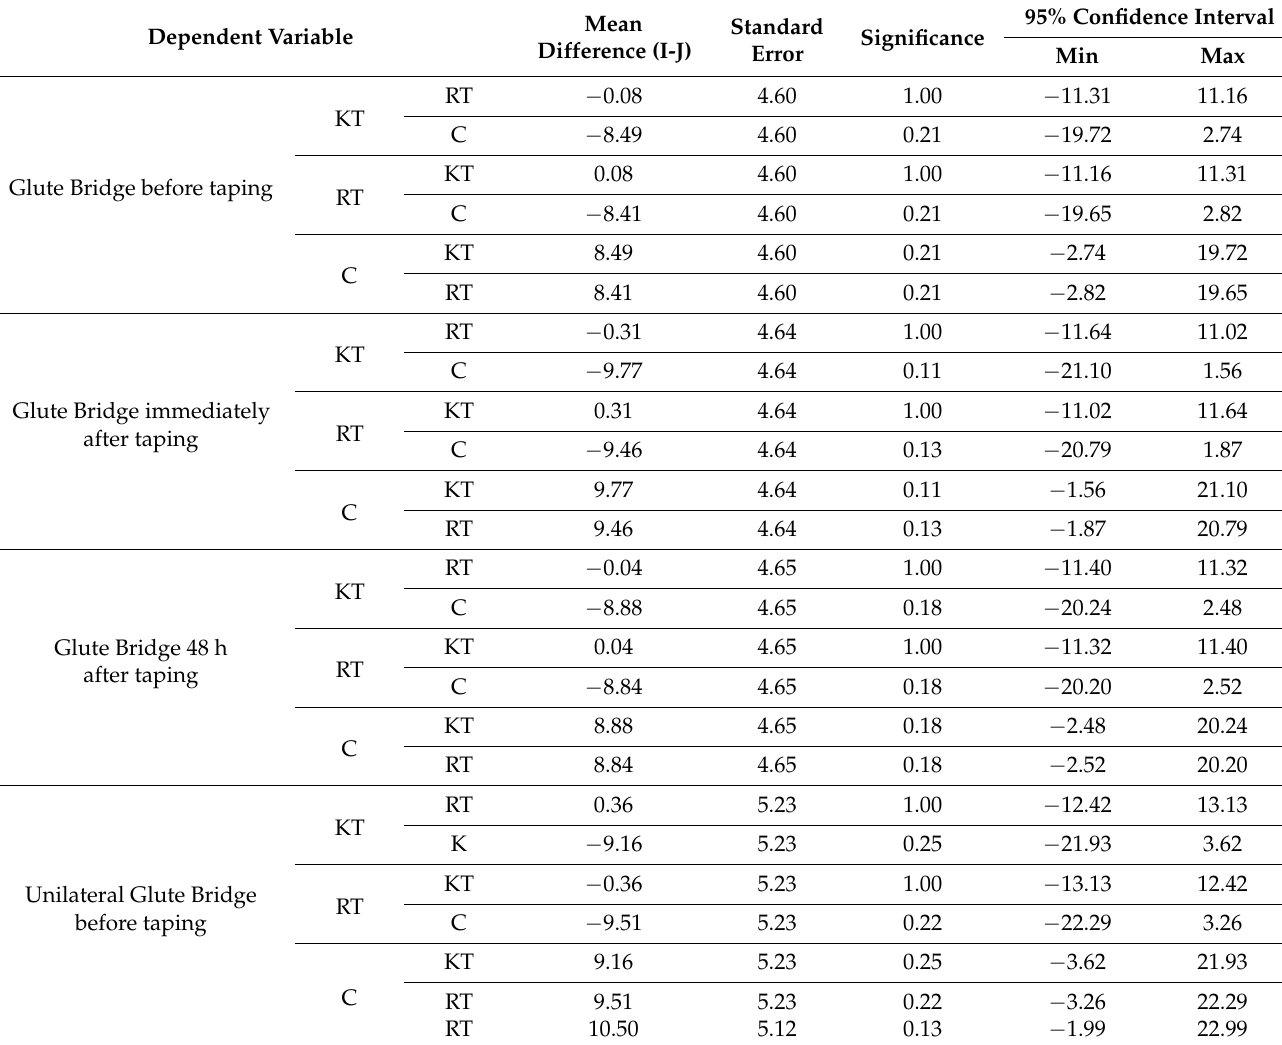
Table 3. Group differences in results obtained for particular exercises (N =